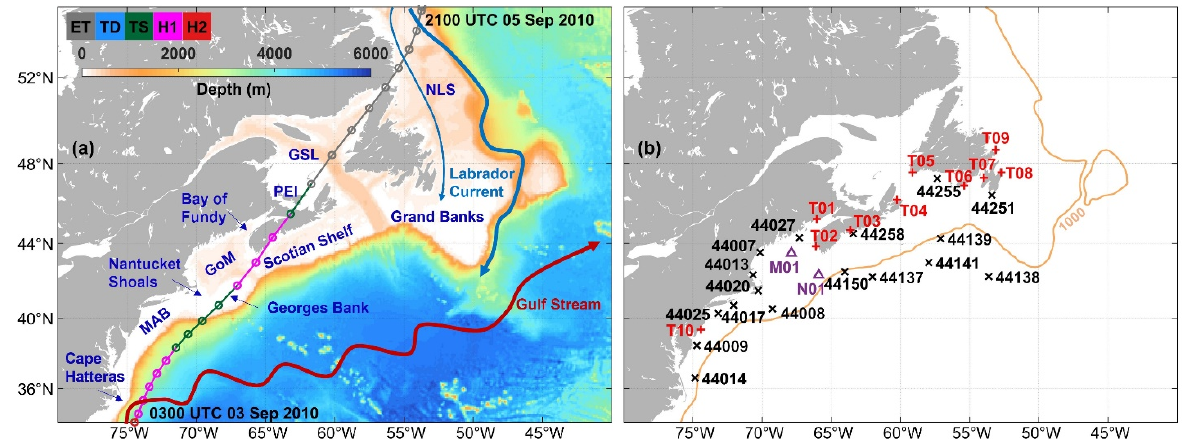
Figure 1. ( a ) Model domain and bathymetry of the NWA. The red and blue lines show the schematic view of the Gulf Stream and Labrador Current, respectively. The solid line with circles shows the storm track and its color represents the strength of the storm (extratropical storm, ET; tropical storm, TS; Category 1 Hurricane, H1; Category 2 Hurricane, H2). Abbreviations: Middle Atlantic Bight (MAB), Gulf of Maine (GoM), Prince Edward Island (PEI), Gulf of St. Lawrence (GSL), and New- foundland and Labrador Shelves (NLS). ( b ) Observational stations for the wave buoy (black cross), tide gauge (red plus), and ADCP (purple triangle).